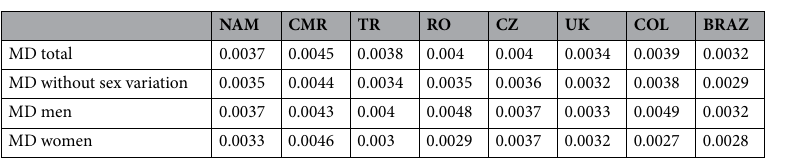
Table 1. Morphological disparity (MD) by population.